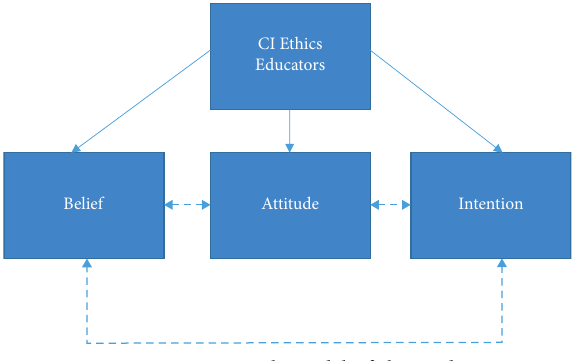
Figure 1: Research model of the